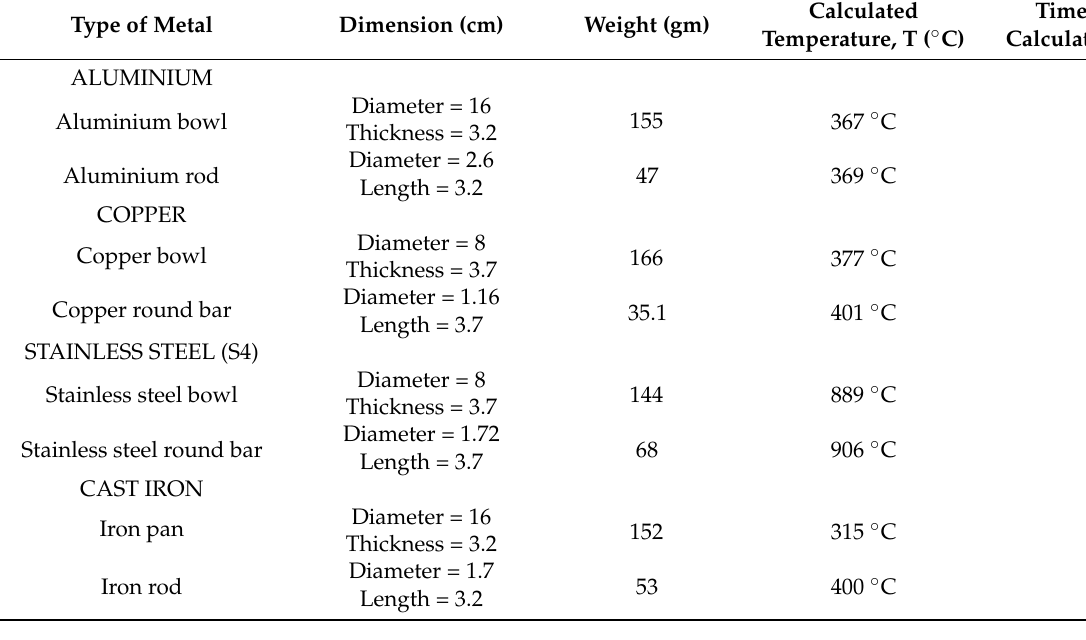
Figure 16. Working coils for ( a ) heating rods ( b ) heating flat vessels.